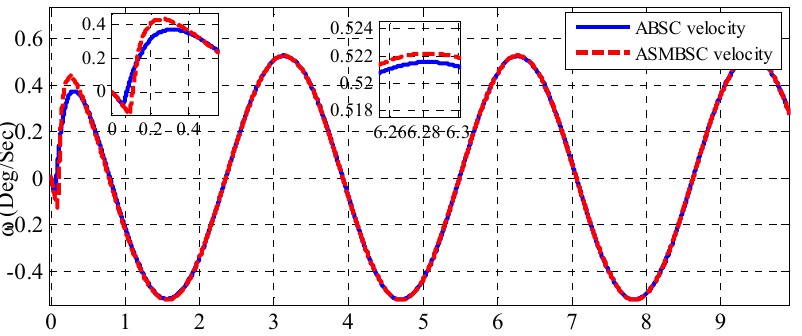
10 of 14 Figure 6. Error response of plate angular position based on adaptive backstepping and adaptive